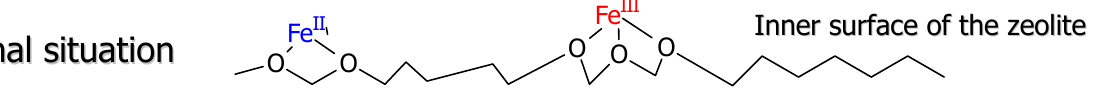
Figure 6: Schematic representation of the different processes involved in the migration from frame- work into extraframework